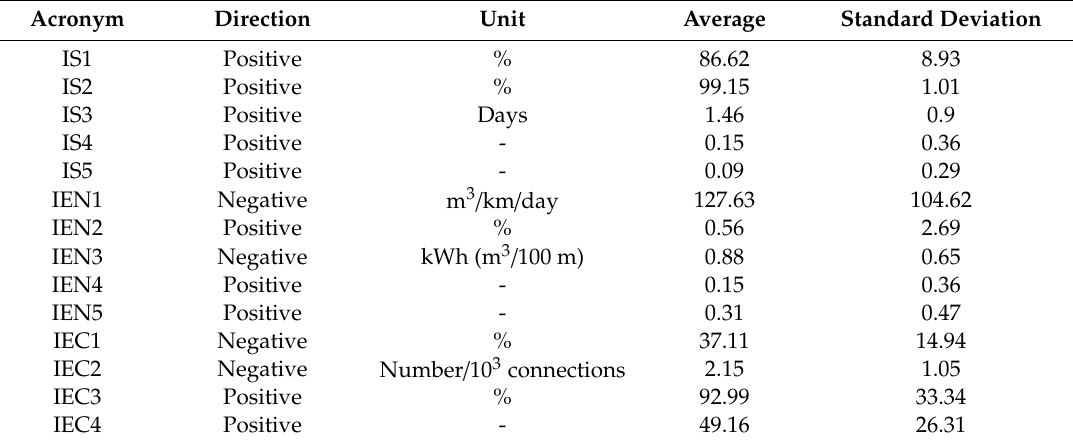
Table 1. Direction of improvement and statistical information from the initial set of PIs.